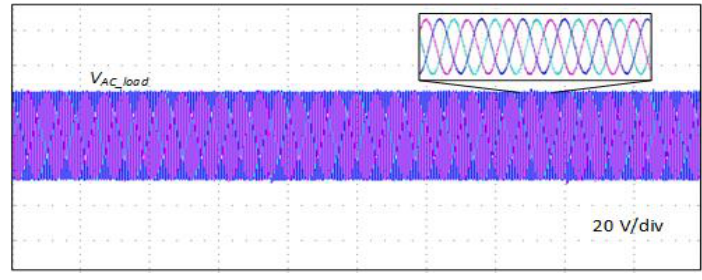
Figure 26. Islanded mode: voltage at AC load.